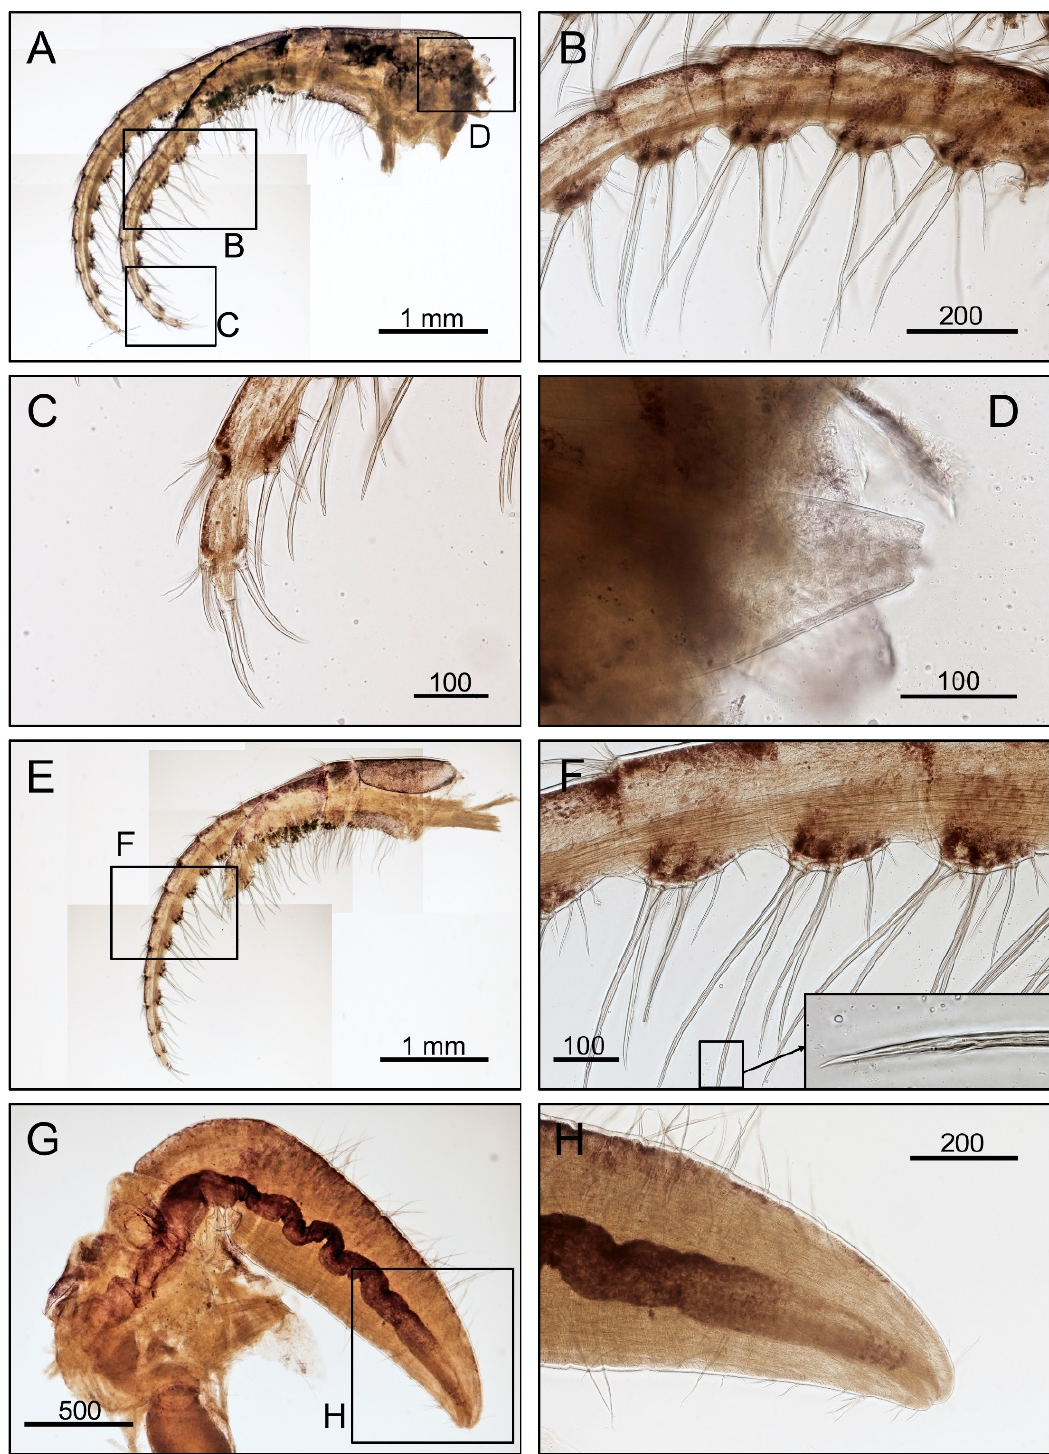
Figure 4. Conchoderma virgatum . ( A ) Cirrus V, with single small filamentary appendage at base, highlighted in D. ( B ) Intermediate segment of cirrus V. ( C ) Distal segment of cirrus V, showing robust simple setae. ( D ) Filamentary appendage at based. ( E ) Cirrus VI. Note one ramus was broken. ( F ) Serrulate setae at intermediate segment of cirrus VI. ( G ) Penis. ( H ) Apex of penis. Scale bars in μ m.